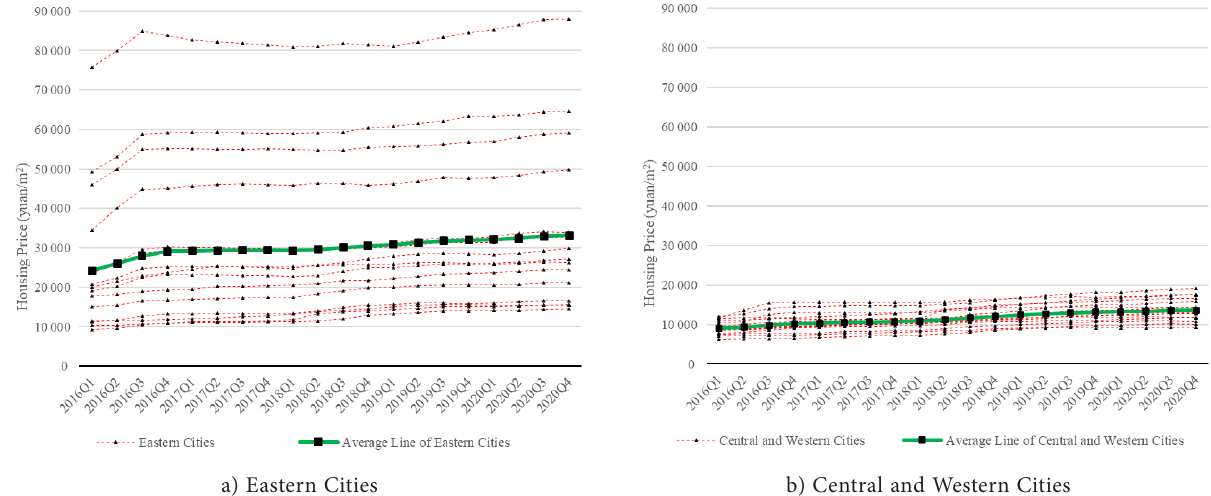
Figure 3. The quarterly housing price in 30 cities in mainland China Table 2. Descriptive statistics for each variable Table 3. Moran’s I values for p and S from 2016 to